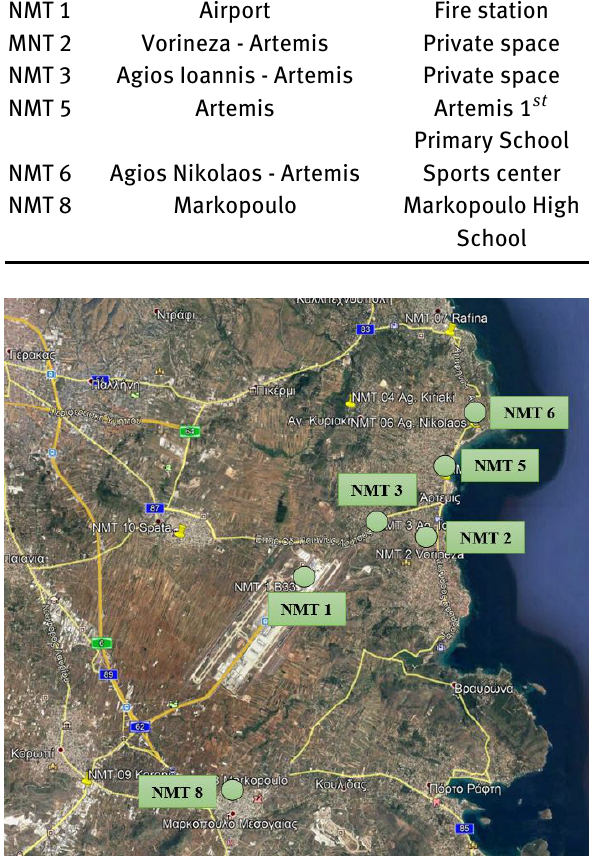
Figure 2: Noise monitoring system of AIA